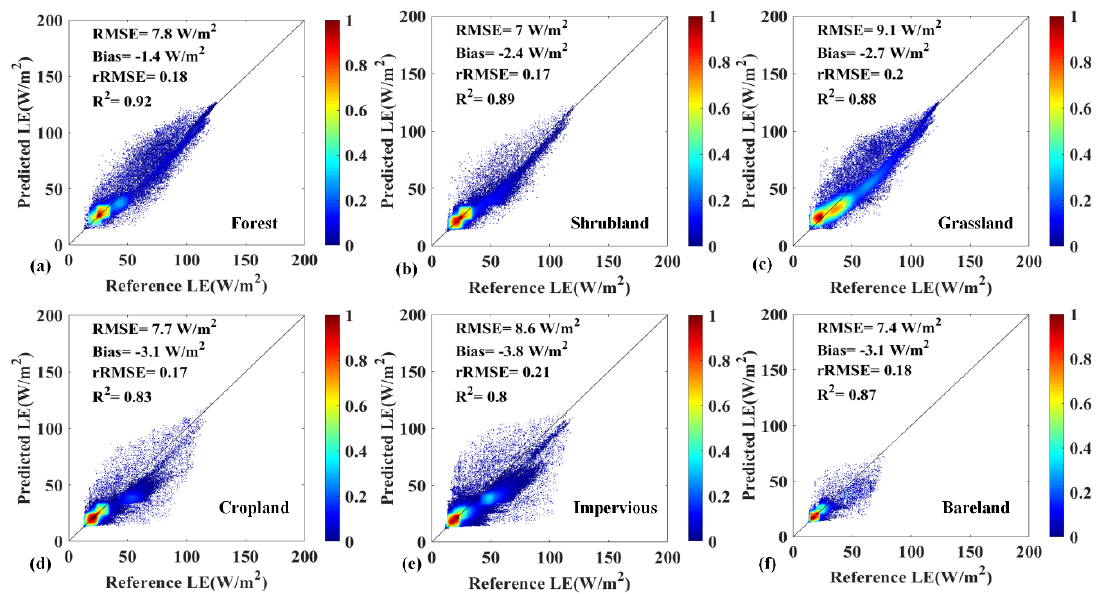
Figure 8. Scatter plots of comparison between estimated LE vs. GF-1 reference LE from Scheme 2 over di ff erent land cover types:( a ) forest; ( b ) shrubland; ( c ) grassland; ( d ) cropland; ( e ) impervious; ( f ) bareland.